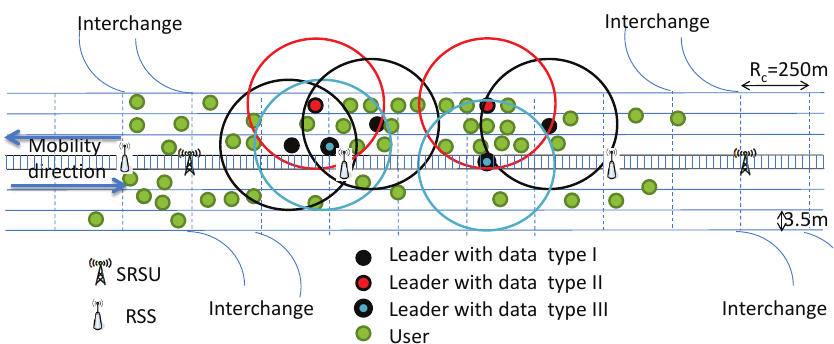
Figure 9. Leader selection without